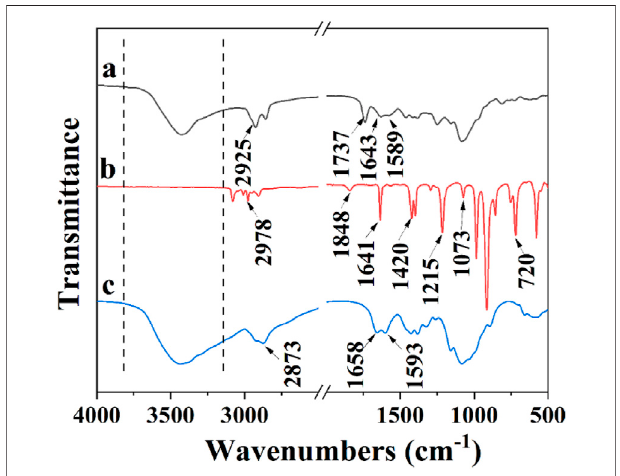
FIGURE 1 | FTIR spectra of ALL@CS (A) , ALL (B) , and CS (C) .